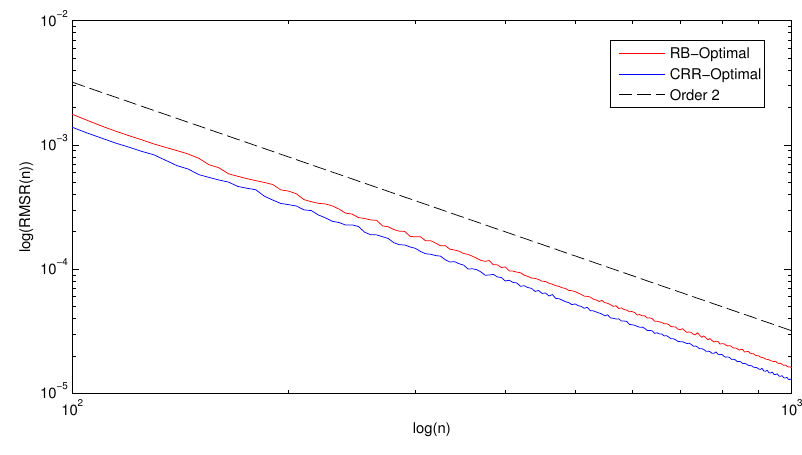
Figure 3. RMSR ( n ) and log ( RMSR ( n ))